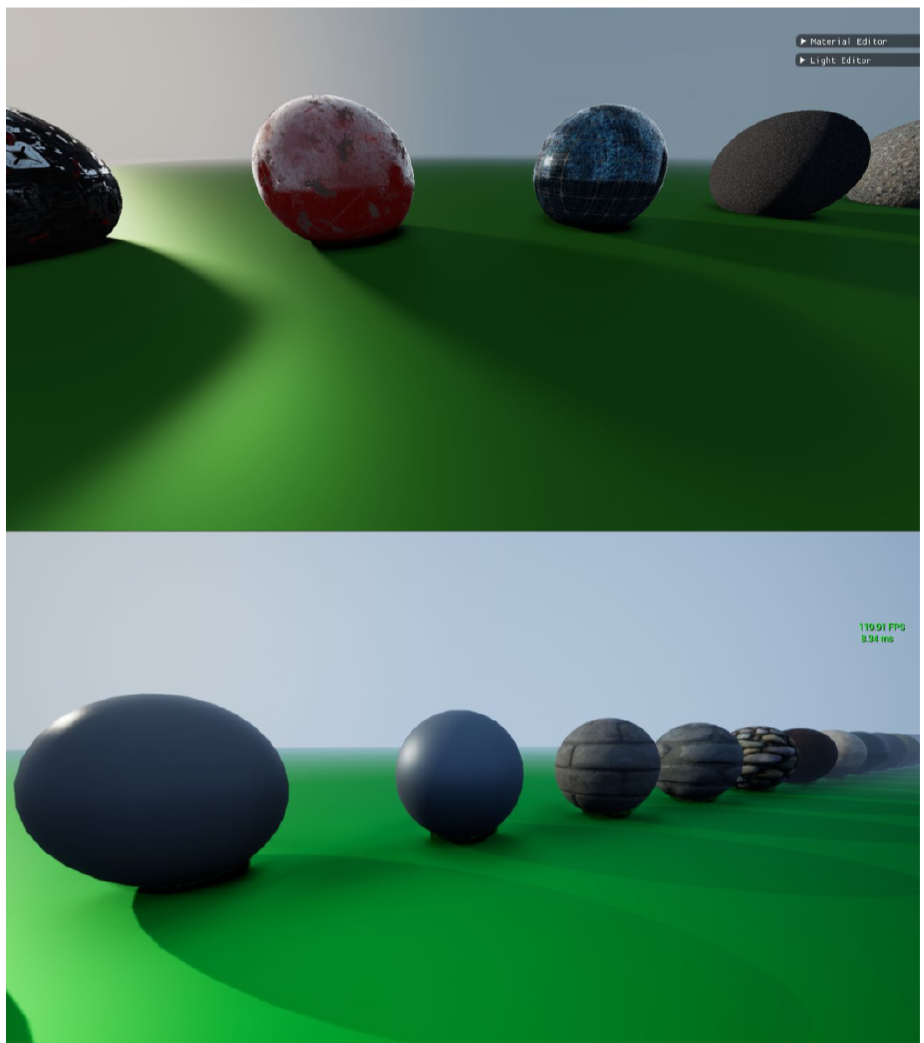
Figure 7. A comparison of soft shadows between our renderer ( top ) and UE4 ( bottom